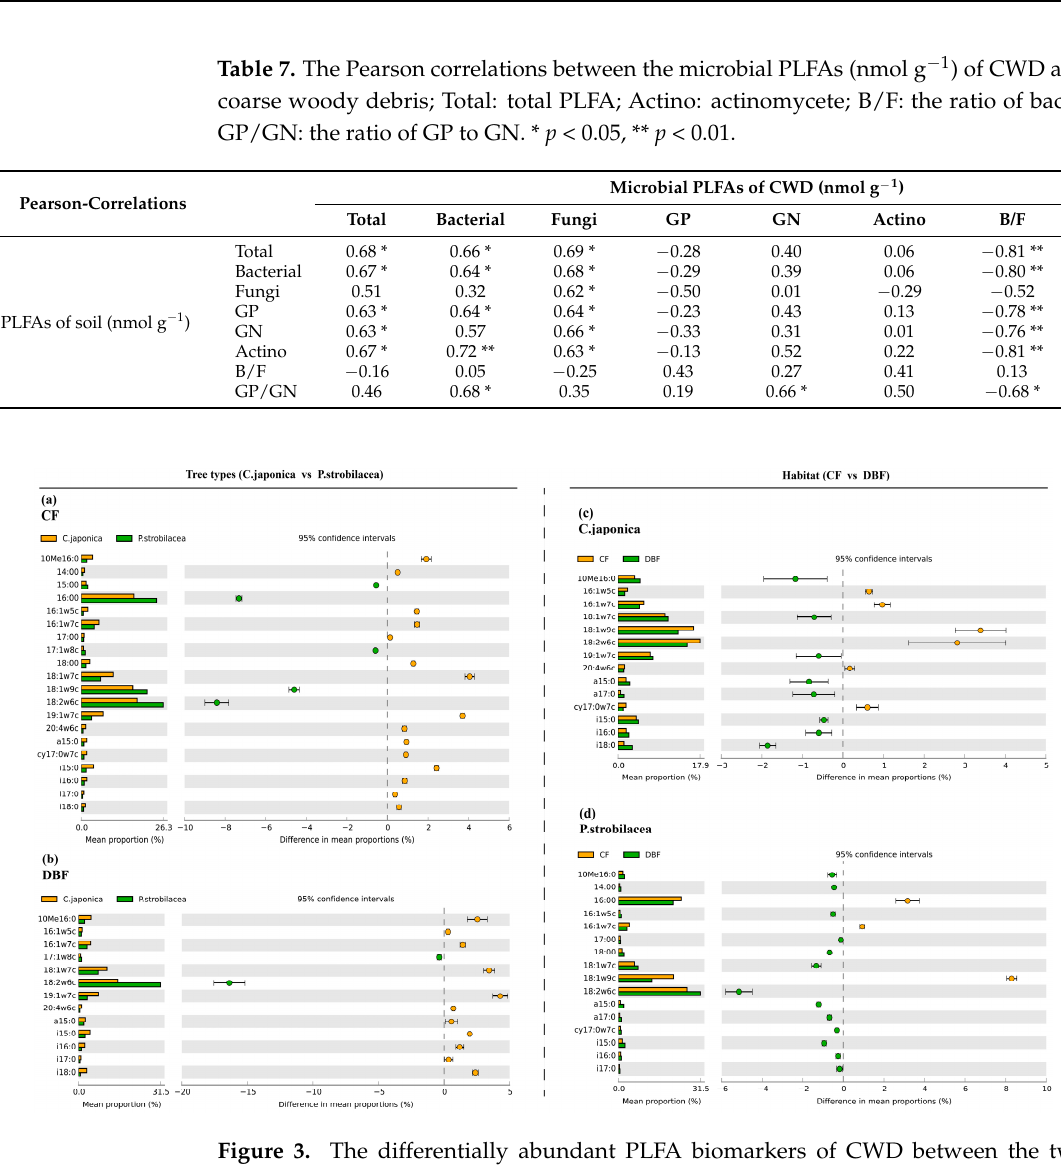
Figure 3. The differentially abundant PLFA biomarkers of CWD between the two tree types ( C. japonica vs. P. strobilacea ) ( a , b ) and the two habitats (CF vs. DBF) ( c , d ). CWD: coarse woody debris; CF: coniferous forest; DBF: deciduous broadleaf